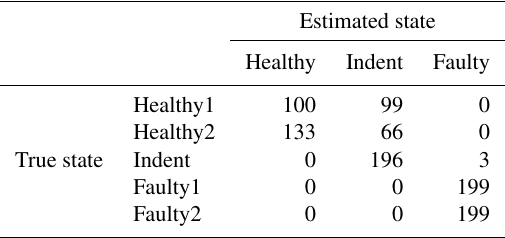
Table 6. Confusion matrix for 3000rpm PCB data and the top three features, classifier trained with ramp-up data.